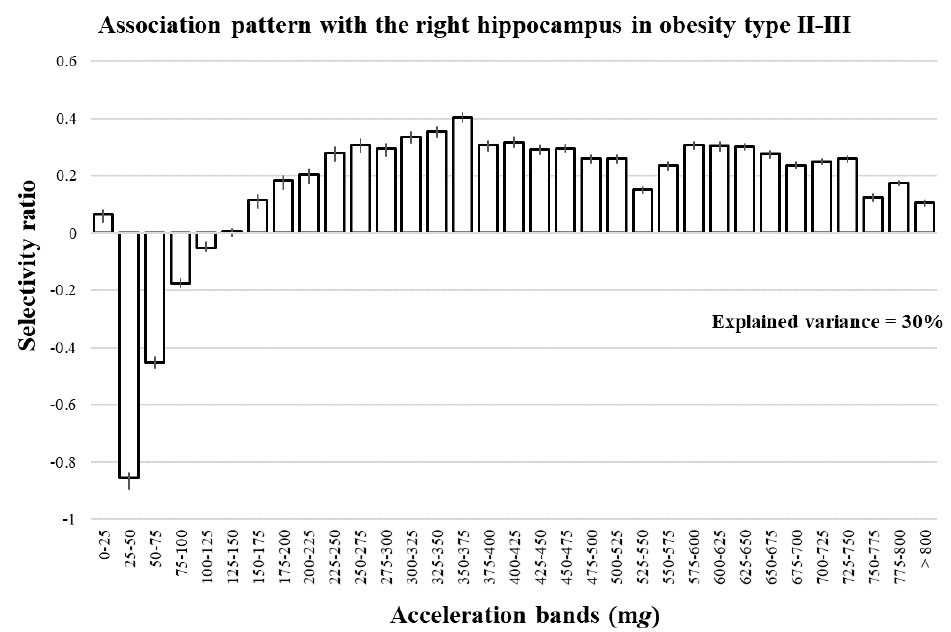
Figure 4. Association pattern of the physical activity spectrum with gray matter volume in the right hippocampus in children with obesity type II–III.